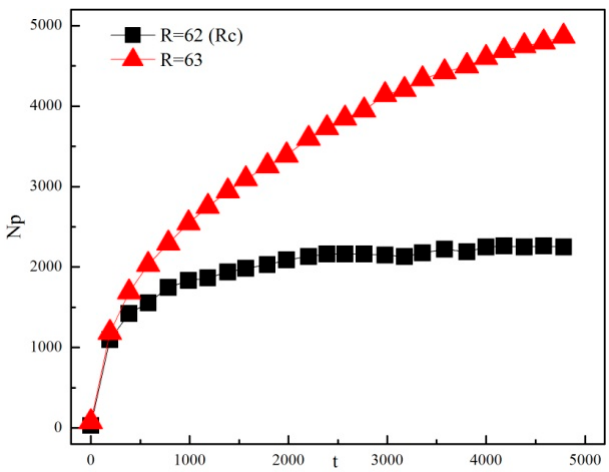
Figure 14. Evolution of packet number Np vs. t for different R under the integrated routing.